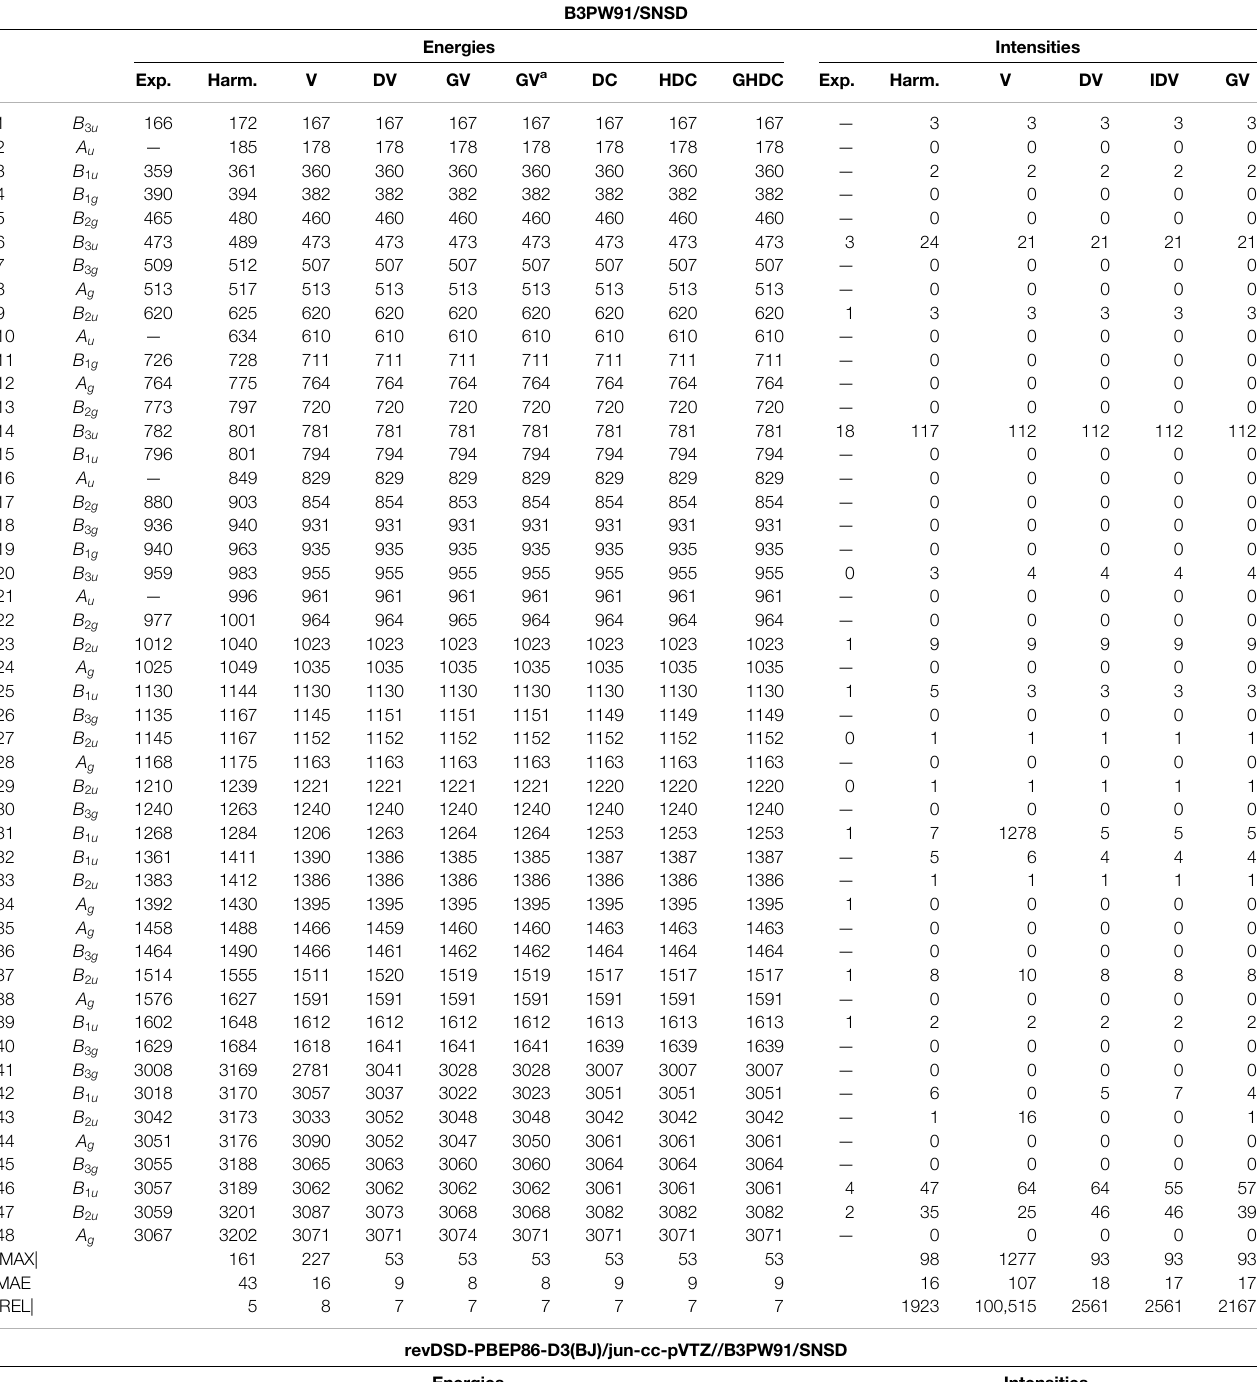
TABLE 7 | Harmonic and anharmonic vibrational energies (in cm − 1 ) and intensities (km/mol) of naphthalene computed at the B3PW91/SNSD and hybrid revDSD-PBEP86- D3(BJ)/jun-cc-pVTZ//B3PW91/SNSDlevelsoftheoryandwithdifferentVPT2schemes.Themaximum(|MAX|)andmean(MAE)absoluteerrors,aswellasthemaximum relative error weighted by the reference value (|REL|, given in %) are reported with respect to experimental data from (Cané et al., 2007). B3PW91/SNSD